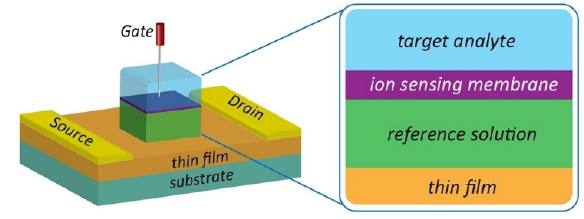
Figure 16. Illustration of twin pool gating FET setup. Indium (III) oxide (In 2 O 3 ) and tin-doped indium oxide (ITO) have been addressed